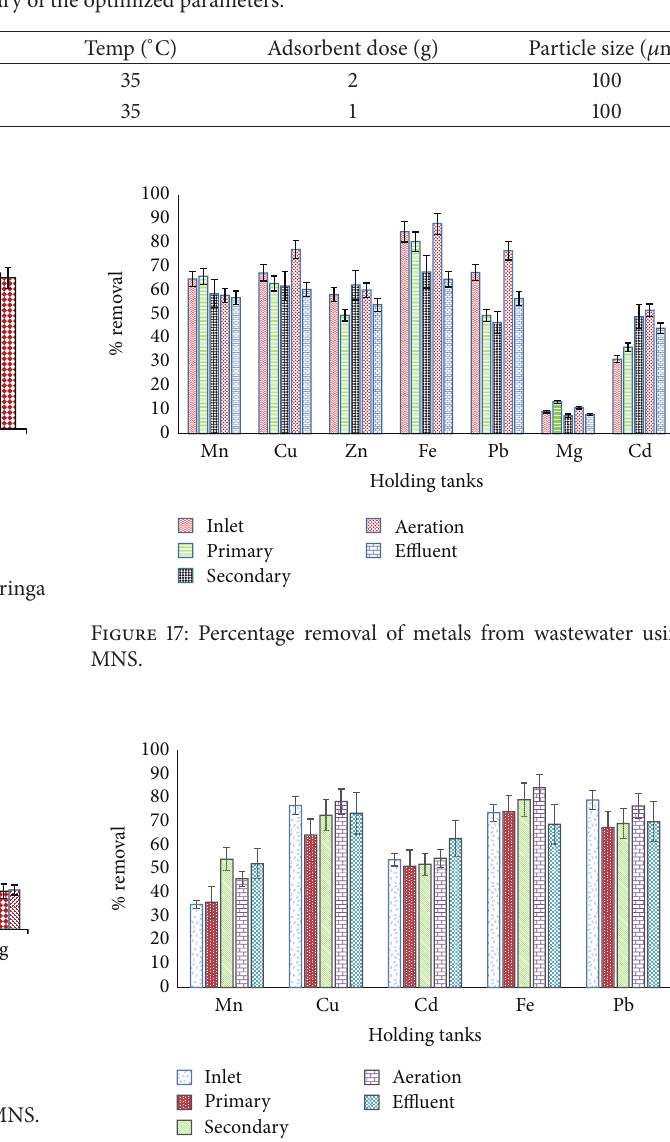
Figure 18: Percentage removal of metals from wastewater using